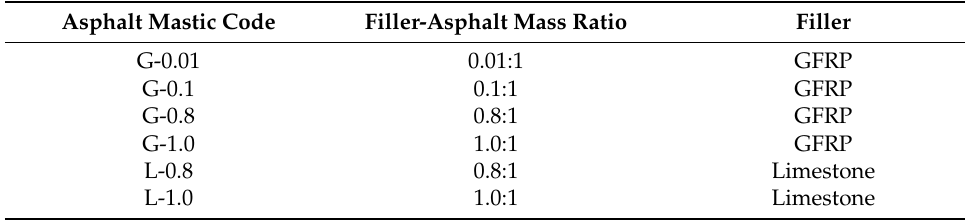
Table 3. Codes of asphalt mastics.